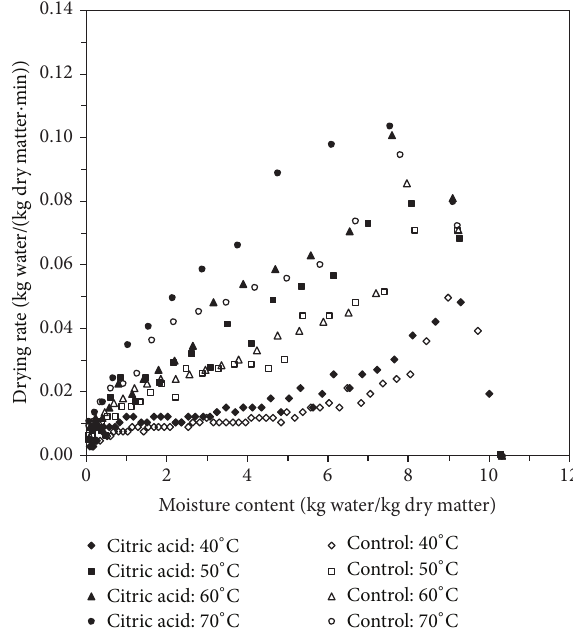
Figure 2: Drying rate versus moisture content of mushroom slices at different